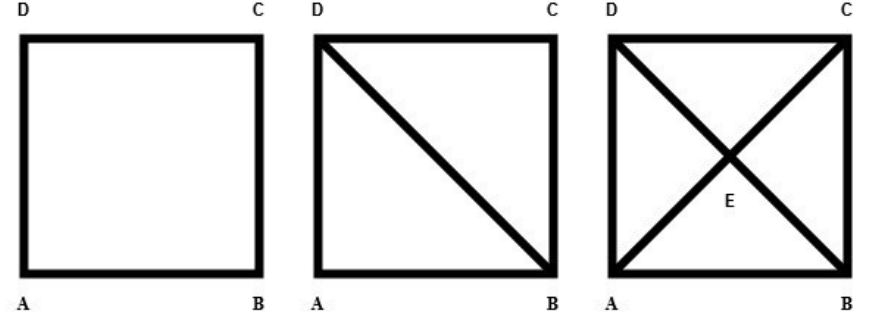
Figure 1. Eulerian path ( left ), semi-Eulerian path ( centre ), non-Eulerian path ( right